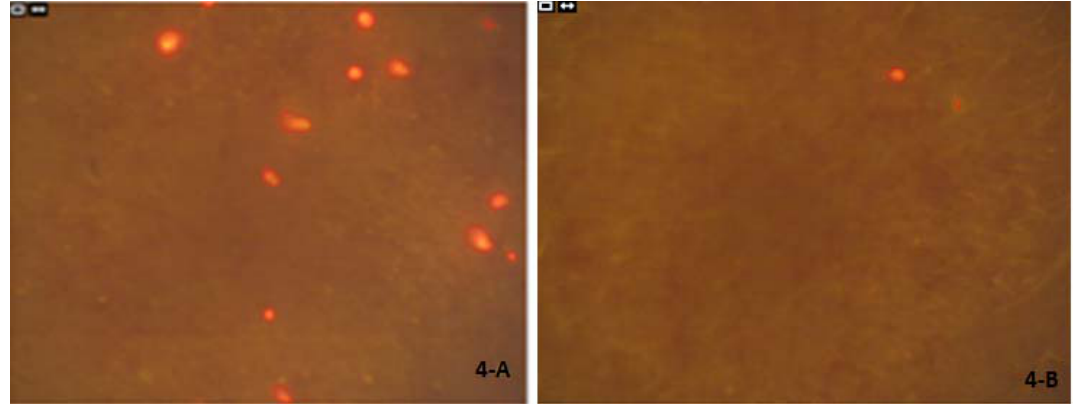
Figure 4. Graphic of typical results for the determination of porphyrins, visualized under UV light. ( 4 ‐ A ): Porphyrins on the cheek on days 0 and ( 4 ‐ B ): Porphyrins on the cheek on day 45, both in volunteer 23. Table 6. Average results of the porphyrins evaluation on the forehead, the right cheek, the left cheek, the chin, and the nose area of volunteers.